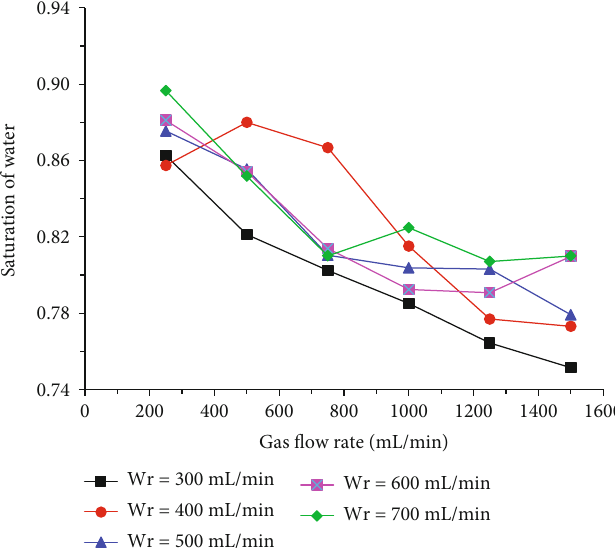
Figure 10: The evolution of water